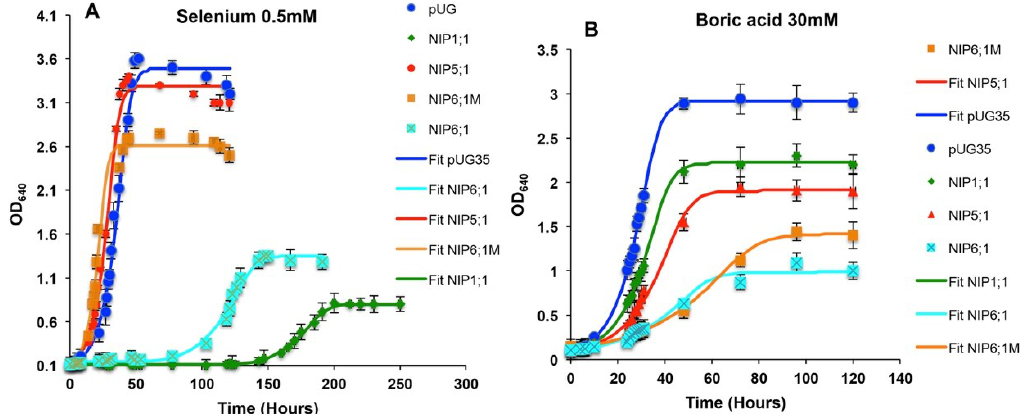
Figure 9. Growth assays of S. cerevisiae strains in the presence of ( A ) selenium (0.5 mM) and ( B ) Boron (30 mM). Yeast cells expressing empty plasmid pUG35 or grapevine NIPs were washed and inoculated (A 260 = 0.1) in the minimal media containing test substrates. Obtained data points of the curve were fitted to the ComBase tool DMFit (online) [30] and growth parameters like lag phase (h), specific growth rate (h − 1 ), and final biomass of the fits were estimated (Table S2). Data is represented in the mean ± SD of at least two independent experiments with three replicates.